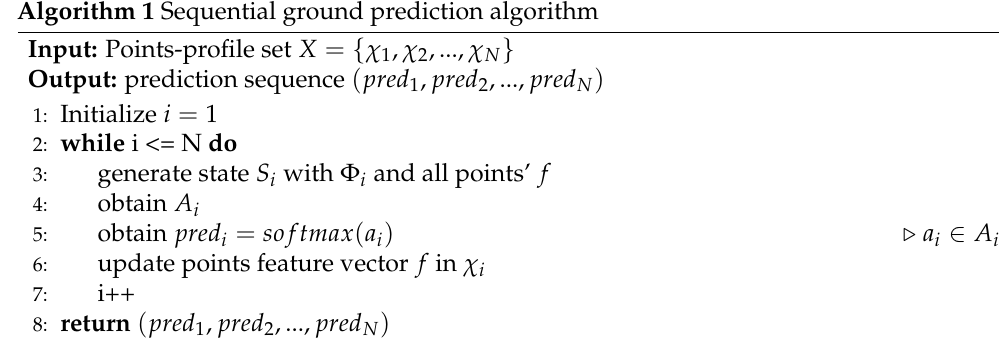
Algorithm 1 Sequential ground prediction